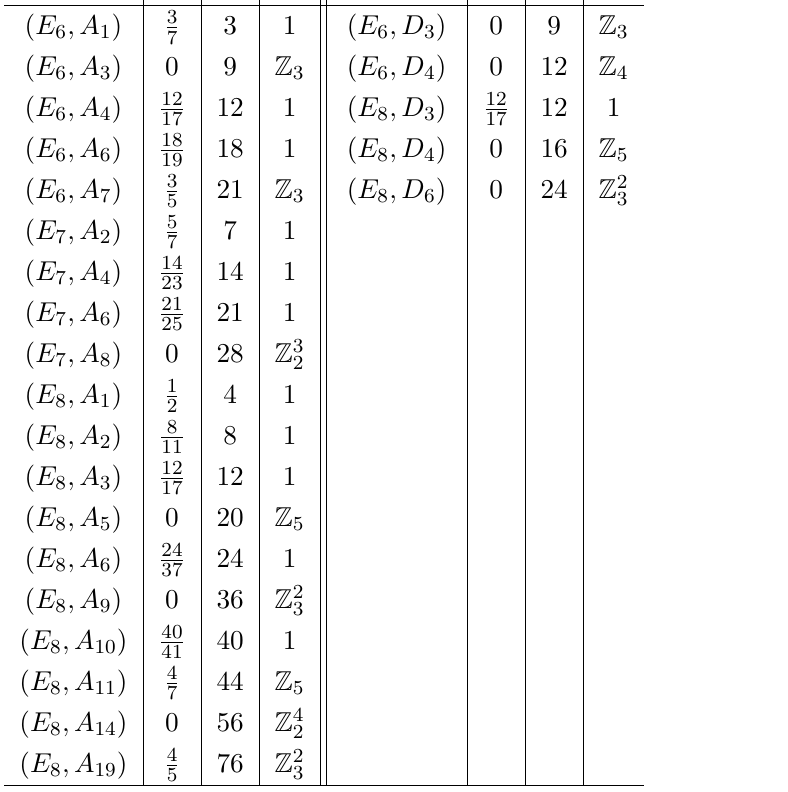
) and ( E ) , with n = 6 , 7 , 8 and 1 ≤ m ≤ 100 . We called h = Table 3 : ( E , A , D n m n m 24( c − a ) , r the rank of the SCFT and s the value of the 1 -form symmetry. We list only those theories with 0 ≤ h < 1